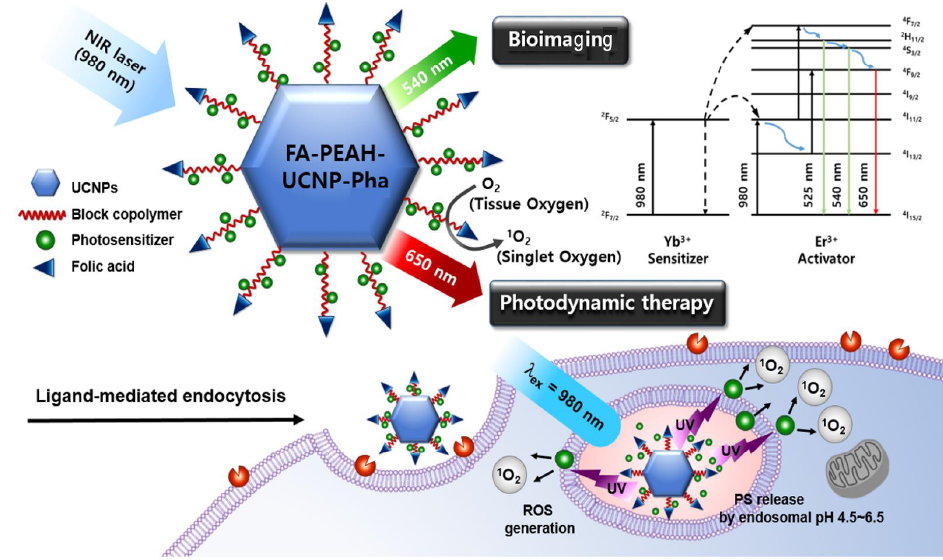
Figure1. Schematicillustrationdemonstratingthephotodynamictherapyandupconversionmechanism of pH-responsive polymer modified (FA-PEAH)-upconversion nanoparticles (UCNPs)- pheophorbide a